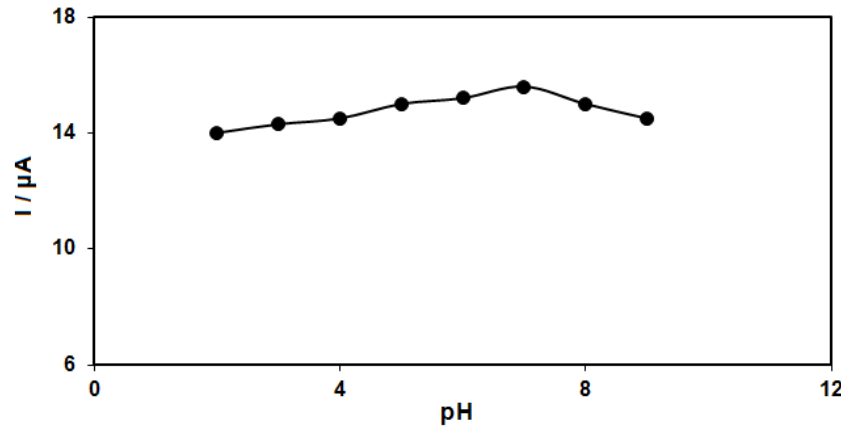
Figure 2. Plot of Ip vs. pH obtained from DPVs of GO–PAMAM/ILCPE in a solution containing 50.0 μ M of catechol in 0.1 PBS with different pHs (2.0, 3.0, 4.0, 5.0, 6.0, 7.0, 8.0, and 9.0).